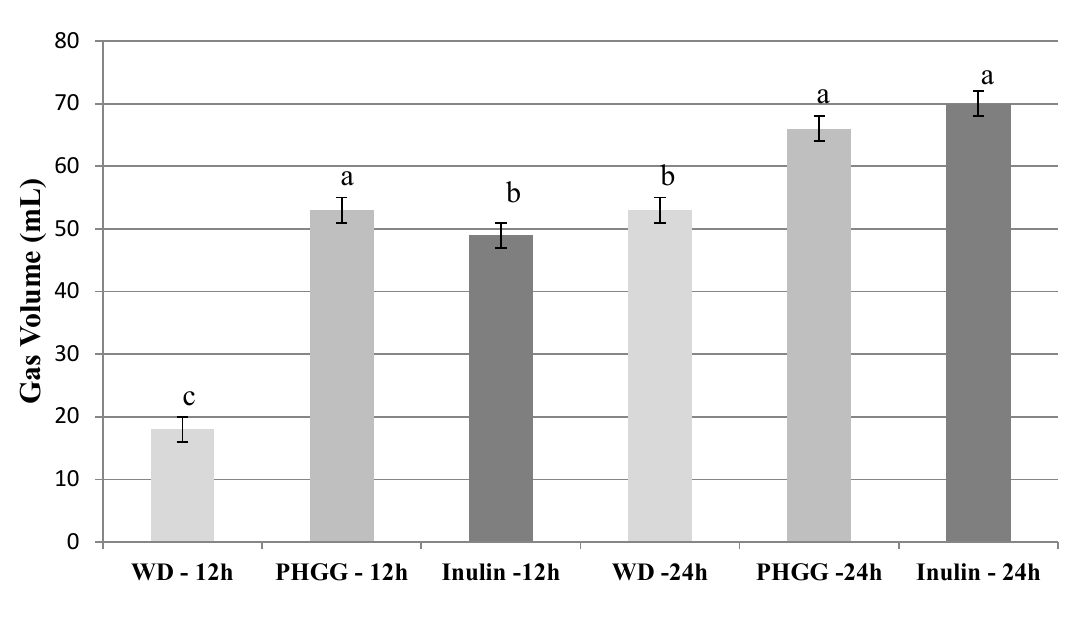
Figure 1. Gas volumes. Values are mean ( n = 3) ± SE. Within a time point (h), treatments with different letters are significantly different ( P < 0.05). Gas production at 0 and 4 h was